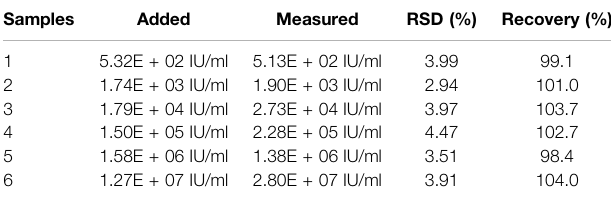
TABLE 2 | Determination results of HBV DNA in clinical serum samples ( n = 4).